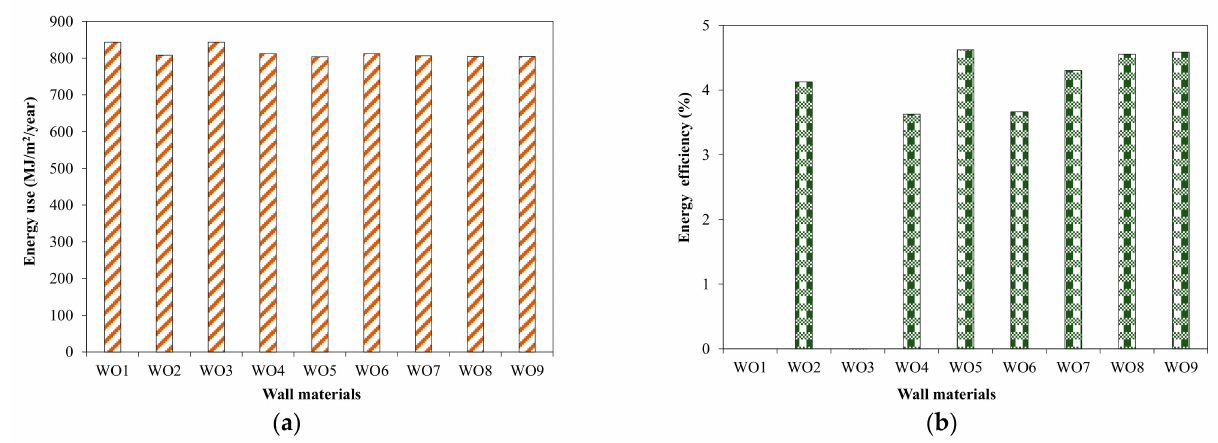
Figure 10. Effect of wall materials on energy use in tested office building. ( a ) Energy use; ( b )